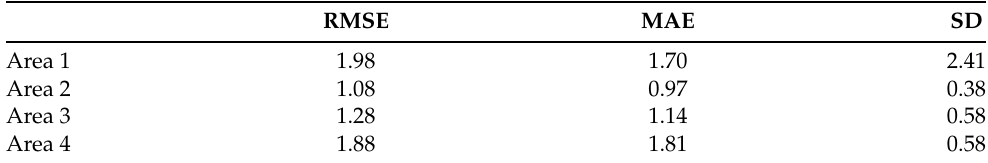
Table 5. Tidal correction evaluation